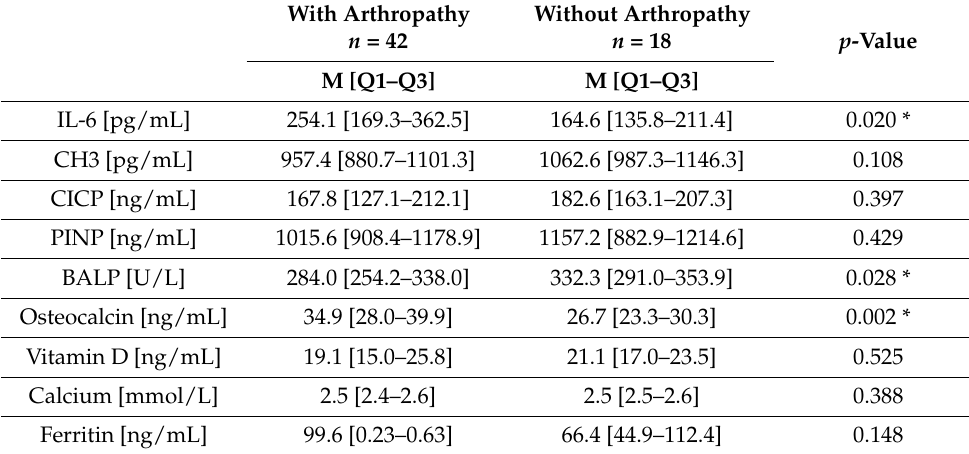
Table 5. Comparison of concentrations of interleukin 6 (IL-6); citrullinated histone CH3 (marker of neutrophil extracellular trap); markers of bone formation (osteocalcin (BGLAP), bone alkaline phosphatase (BALP), N-terminal propeptide of type I procollagen (P1NP)); bone resorption marker- C-terminal telopeptide of type I collagen (C1CP); and vitamin D, ferritin and serum calcium between patients with and without haemophilic arthropathy (median and Q1–Q3). With Arthropathy Without Arthropathy n = 42